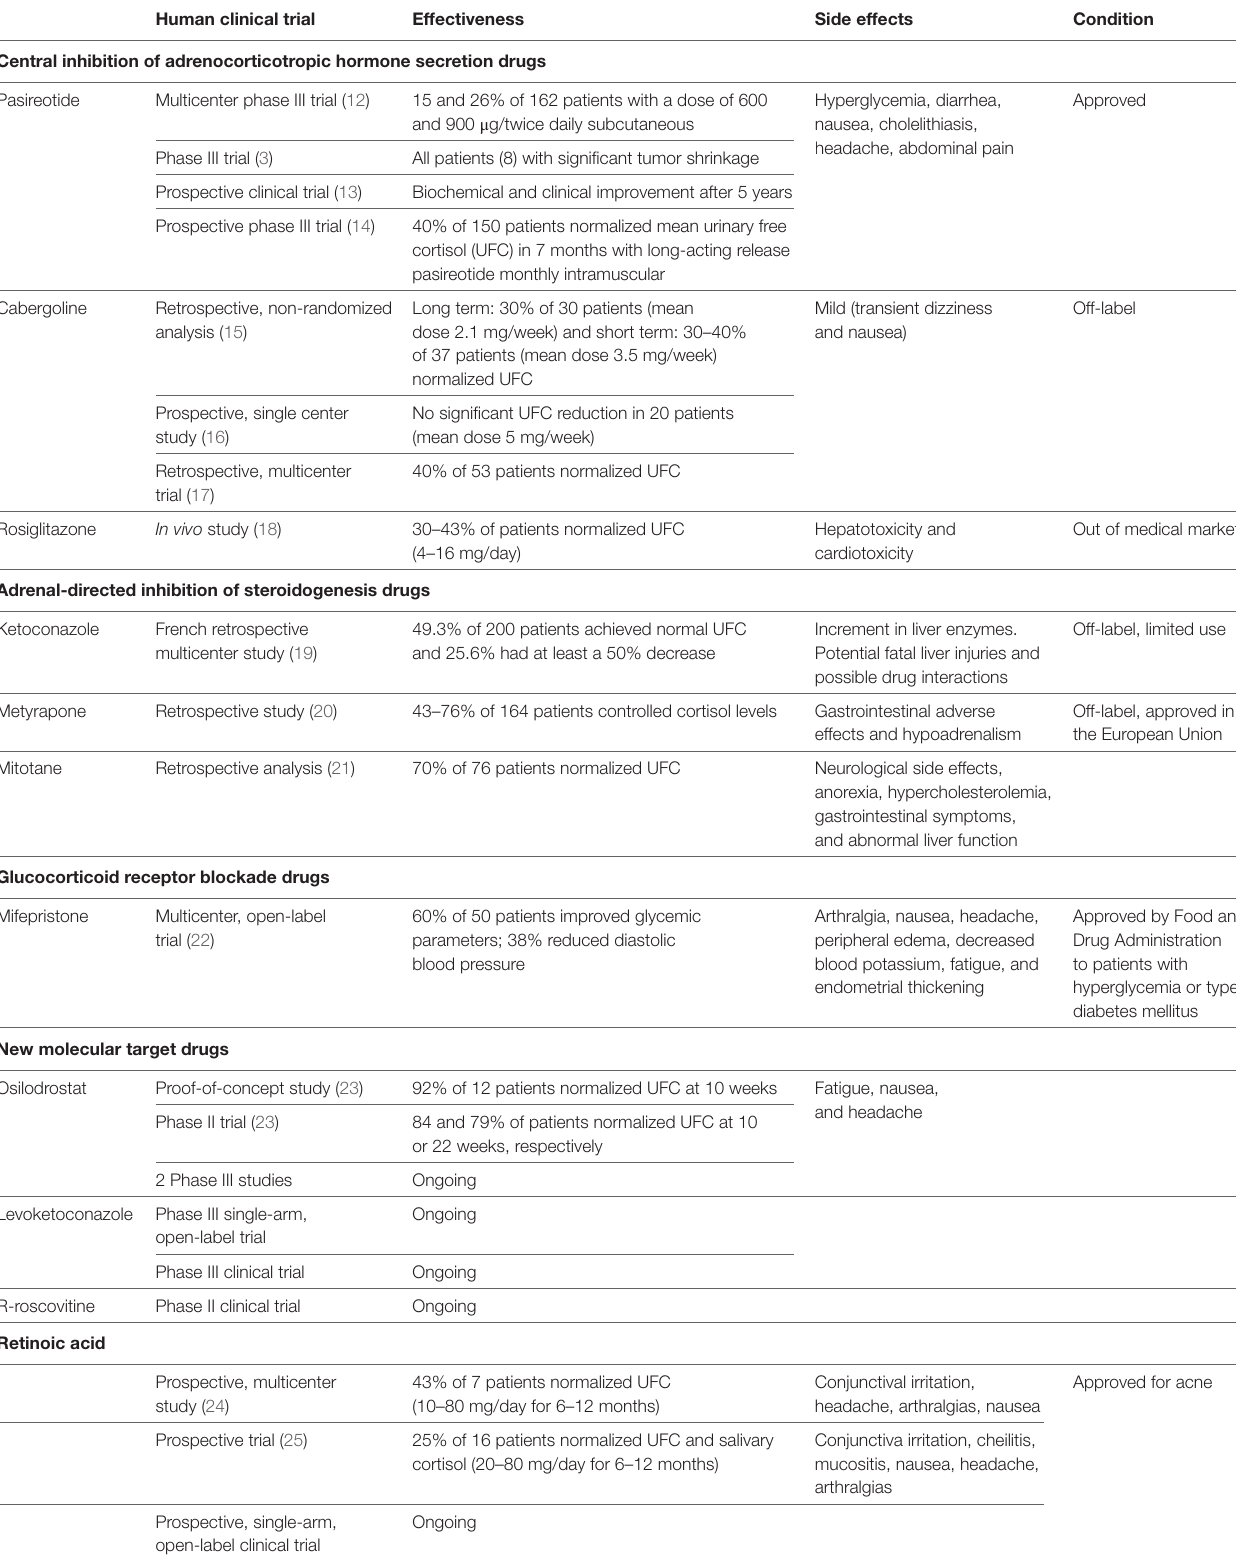
TAble 1 | Summary of pharmacological therapy and clinical trials of